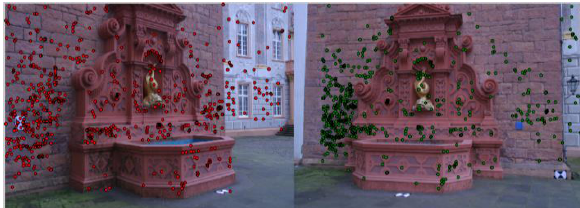
Figure 1. Result of SIFT algorithm in case of the wide-baseline images